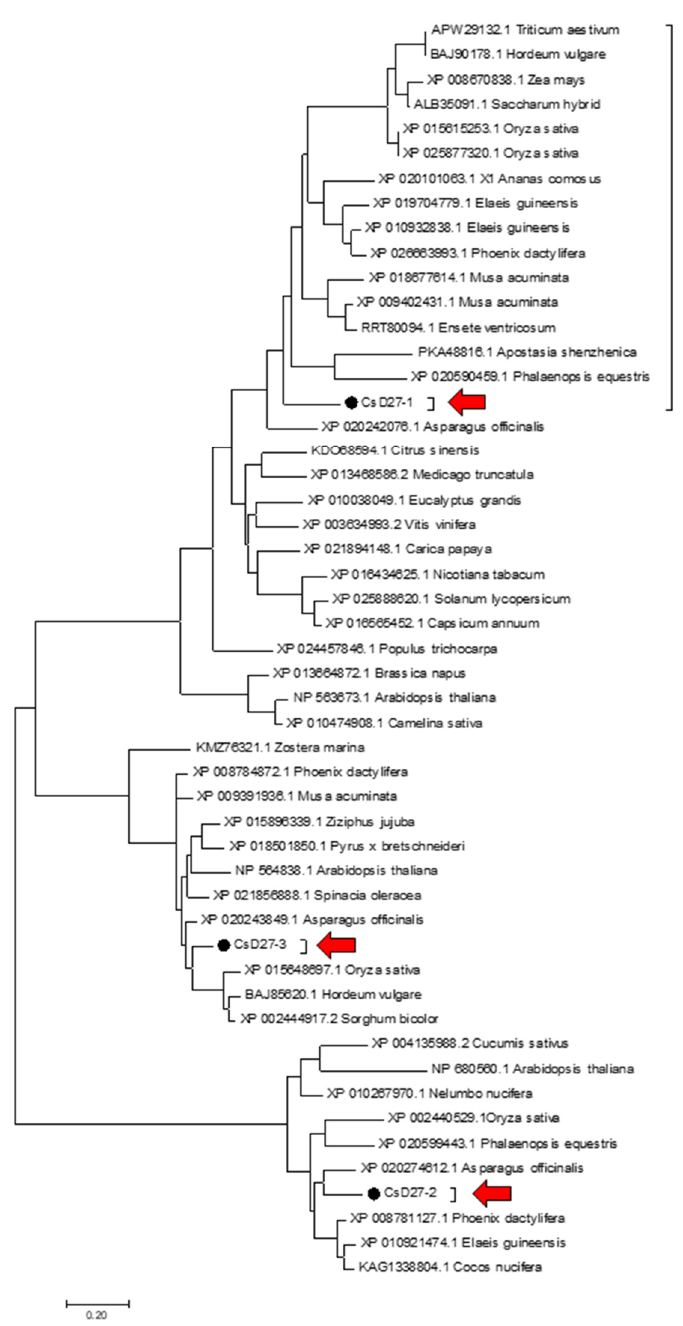
Figure 3. Phylogenetic tree of the CsD27 amino acid sequences with other plant members of the D27 family. The unrooted phylogenetic tree was constructed using MEGA7 from the D27 sequences retrieved from the GenBank database. Evolutionary relationships were inferred using the Neighbor-joining method with 2500 bootstrap re-sampling strategy. The D27 sequences from saffron are highlighted by black dots and red arrows.